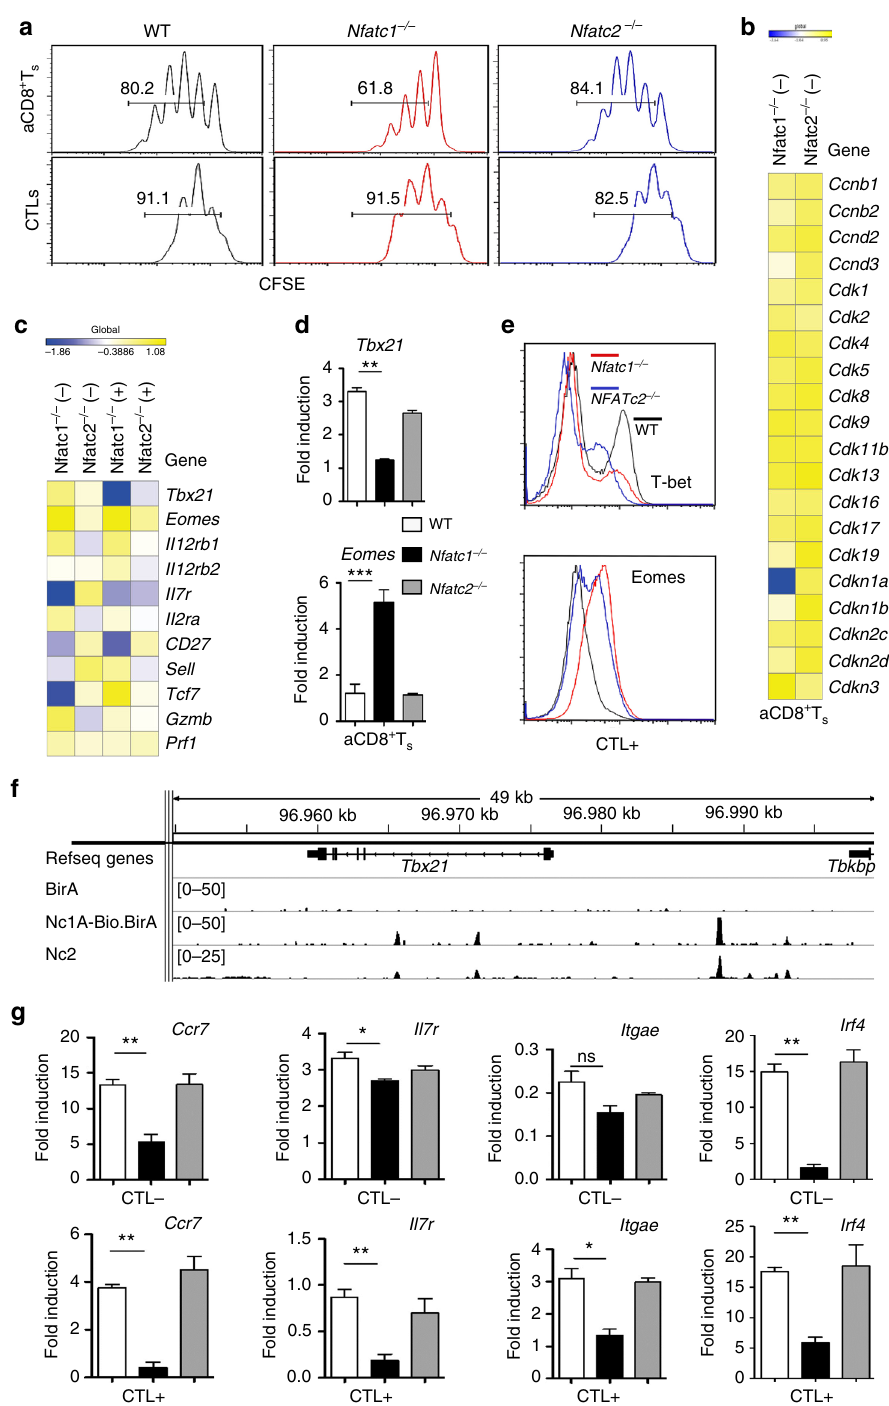
Fig. 6 NFATc1 ablation affects the proliferation and differentiation of CD8 + T cells. a CFSE labeling of aCD8 + T cells stimulated for 3 d by plate-bound α CD3/CD28 (0.05/2 μ g/ml), and of CTLs which were stimulated by α CD3/CD28 (5/2 μ g/ml) for 3 d followed by IL-2 for 5 d. b Heat map of selected genes controlling the proliferation of Nfatc1 − / − ( Nfatc1 f/f x CD4-cre mice) aCD8 + Ts. c Heat map of selected genes affecting the fate of CD8 + Ts. d Real- time PCR assays of Tbx21 and Eomes RNA expression in CTL + cells, normalized by Actb and relative to naïve CD8 + T cells. e Flow cytometry of intracellular T-bet and Eomes expression in CTL + cells. f ChIP seq assay of NFATc1/A-Bio and NFATc2 19 binding to the Tbx21 gene in CTL + cells. g Real-time PCR assays of Ccr7 , IL7r , Itgae and Irf4 RNA expression in CTLs, normalized by Act β and relative to naïve CD8 + T cells. Data from fi ve PCR assays are shown as means ± SEM. Unpaired Student ’ s t -test was used for